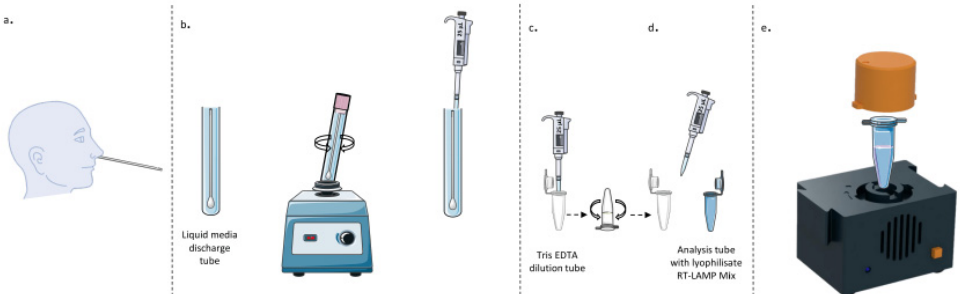
Figure 2. RT-LAMP assay (LoopDeetect COVID-19). After blowing the patient’s nose, the nasopha-